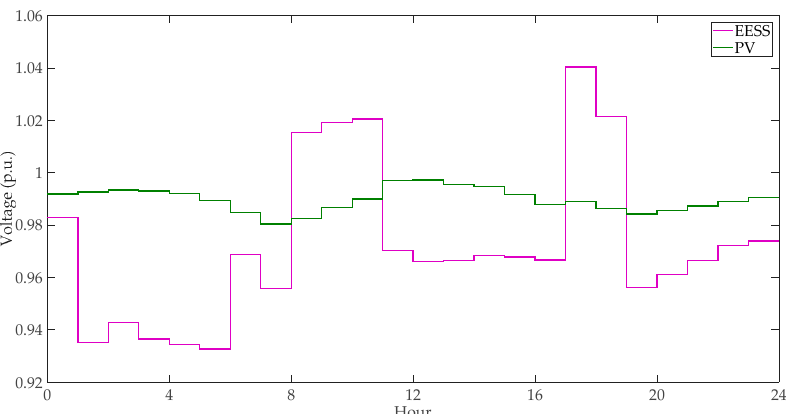
Figure 8. Voltage values along a day of the first year of the planning period at the bus where EESS (bus #6) and PV unit (bus #16) are connected (case study 1).